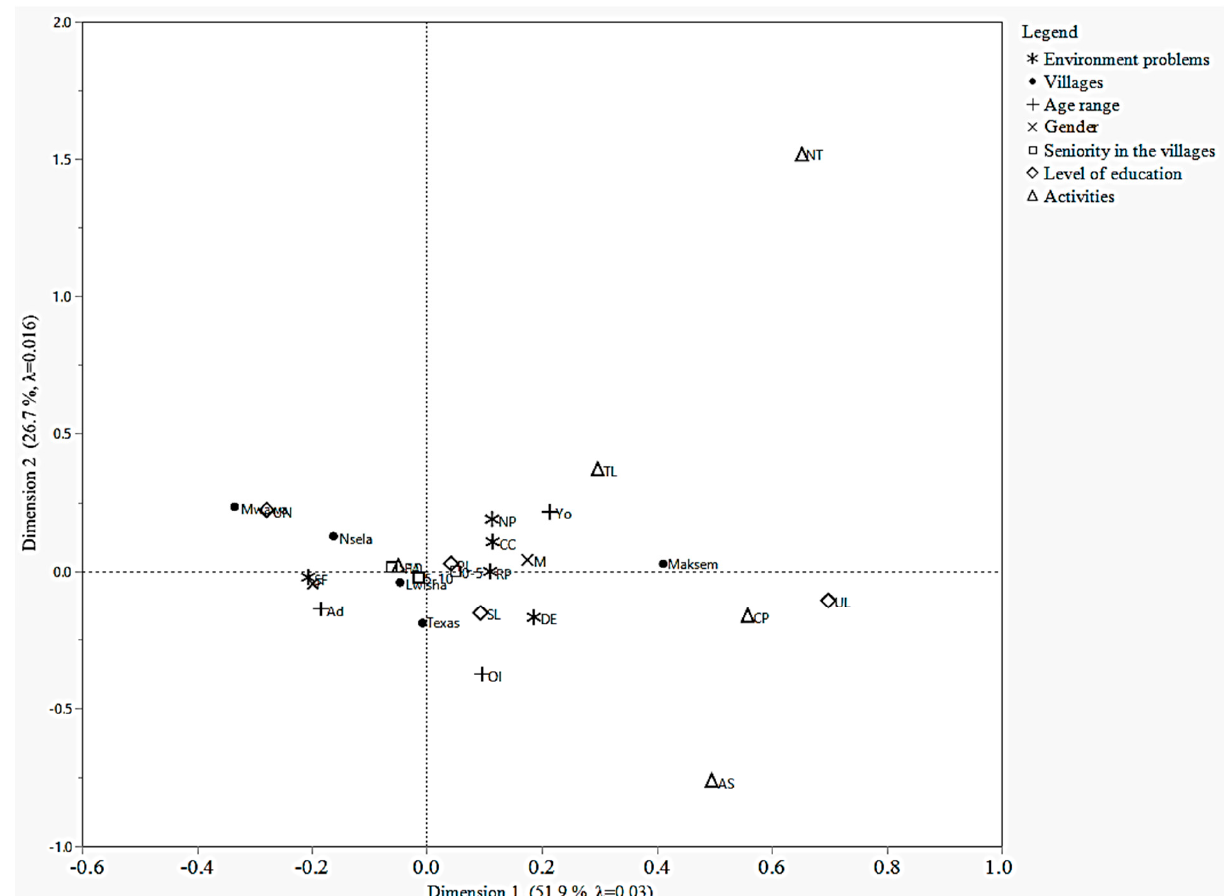
Figure 2. Determinants of local communities’ perception of environmental problems in the different villages of the rural area of Lubumbashi, depicted in a plan consisting of the first two dimensions summarizing 78.6% of the information following a multiple correspondence factor analysis. F : Fe-